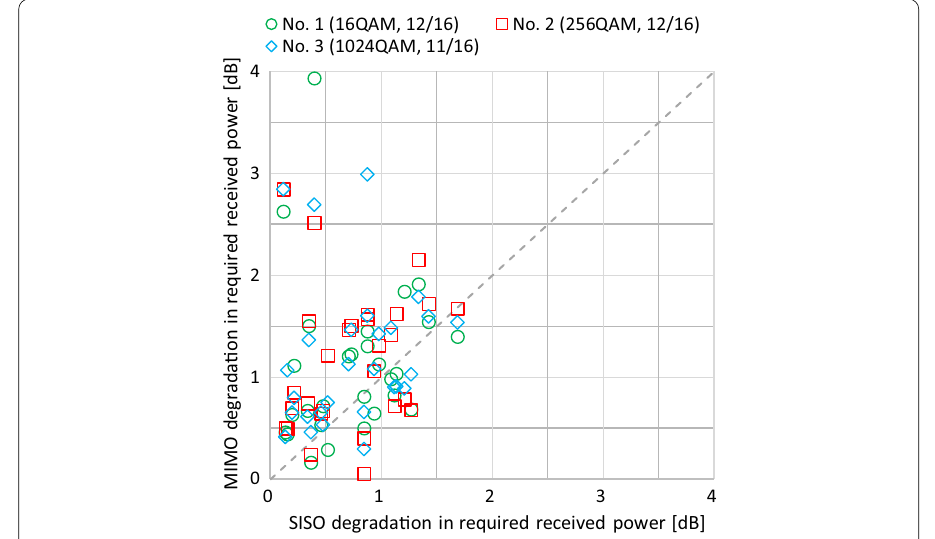
Fig. 17 Comparison of degradation in required received power between SISO and MIMO in field experiments